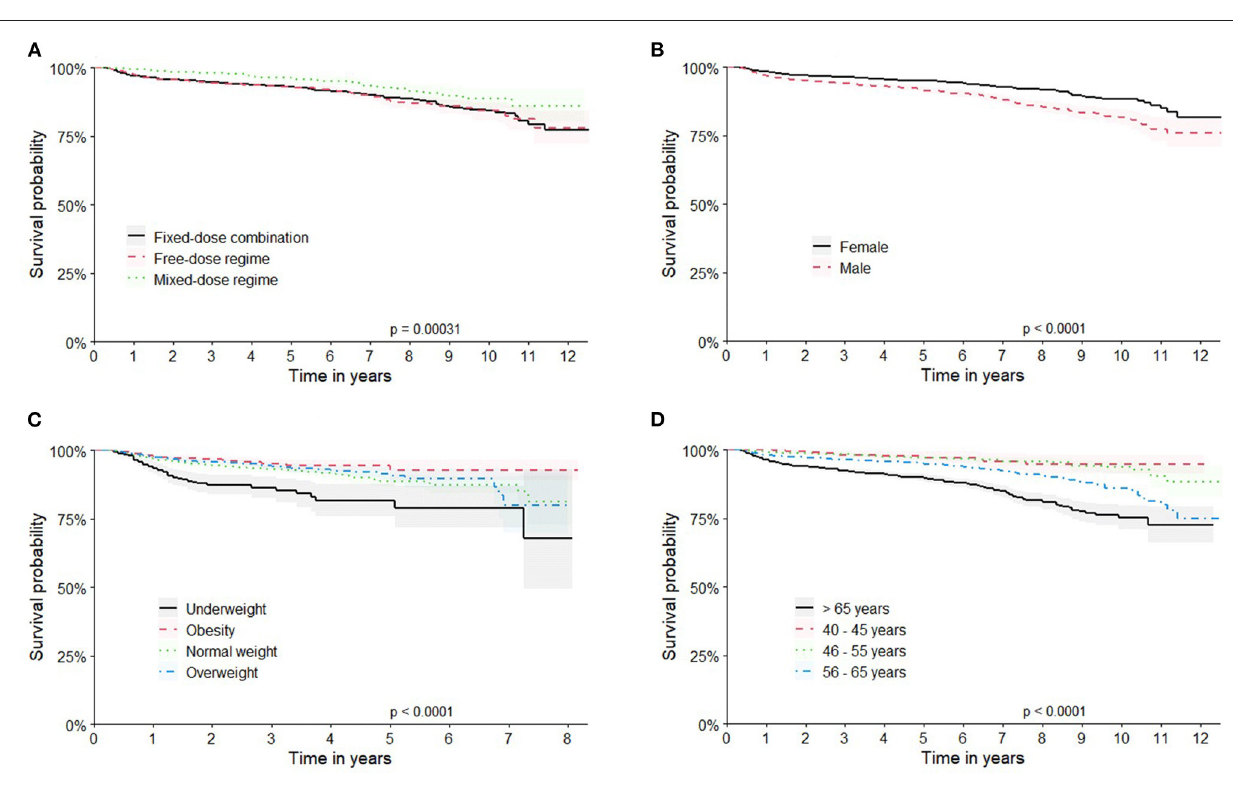
FIGURE 3 | Kaplan-Meier curves for patient survival in the Matched cohort. Longitudinal survival by: (A) therapeutic regimens; (B) patient’s sex; (C) Body Mass Index category; (D) age group. Survival rates were estimated by Kaplan-Meier methodology and compared by log rank